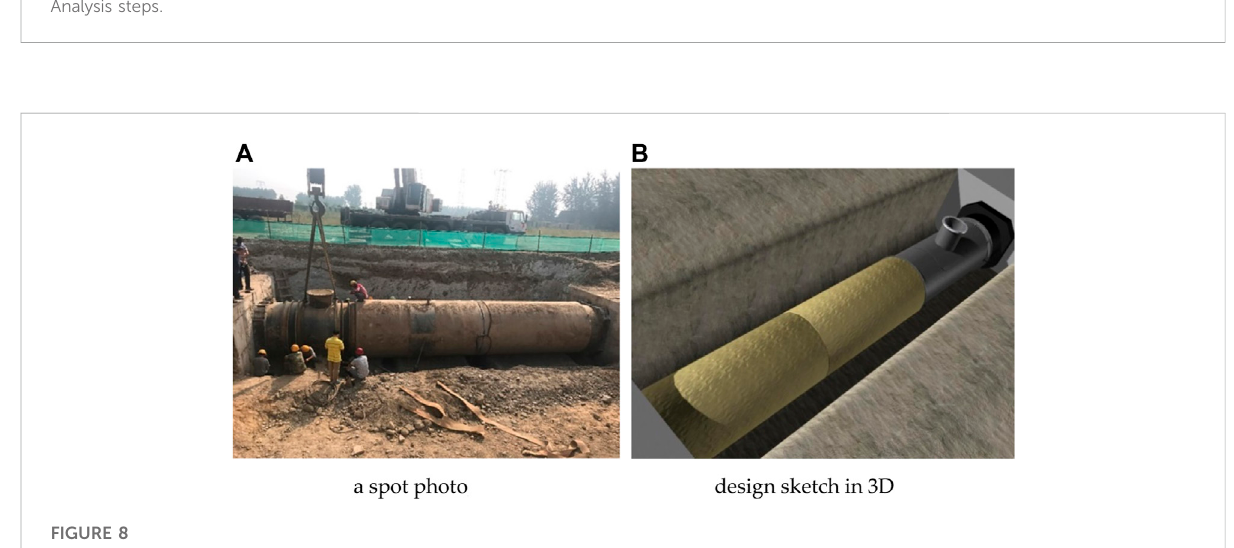
process were analyzed. Once the real strain of the concrete core (Feng, 2008; GB, 2015) reaches 207 × 10 − 6 , micro-cracks begin to occur. The strain of 1522 × 10 − 6 in the concrete core indicates the onset of macro-cracks.